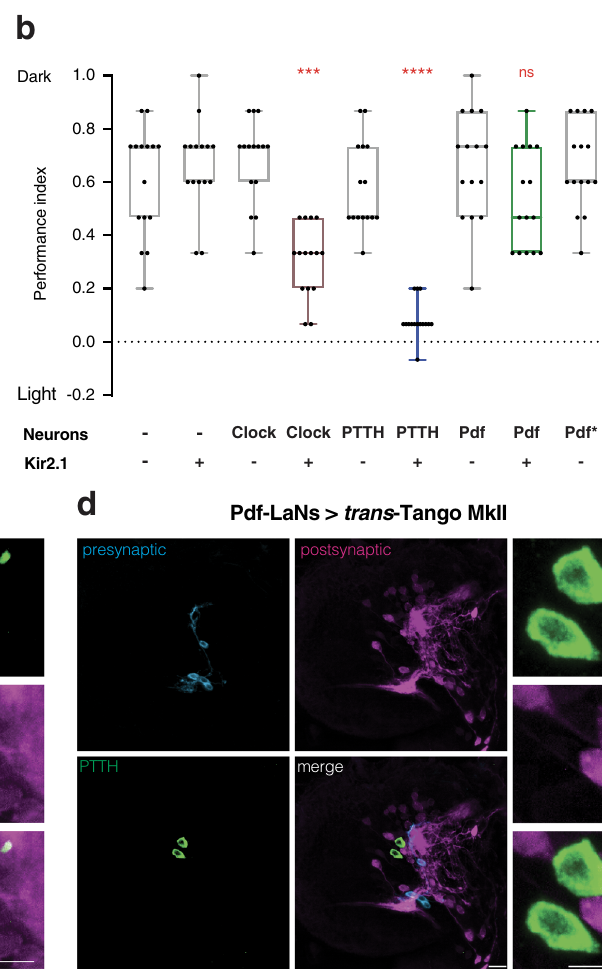
*** p <0.001, **** p <0.0001. n =15 trials for each group. c Expression of the trans- TangoMkIIligandinallclockneuronsrevealspostsynapticsignalinPTTHneurons. d trans- TangoMkII reveals that PTTHneurons are not postsynaptic to Pdf-LaNs. In panels c and d , presynaptic GFP (cyan), postsynaptic mtdTomato-HA (magenta), and PTTH (green) are shown. Scale bars, 10 μ m. Source data are provided as a Source Data fi